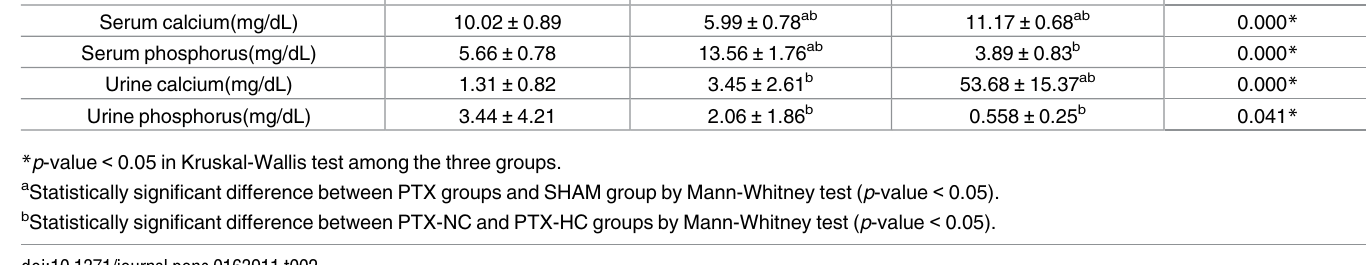
Table 2. Serum and urine calcium and phosphorus levels on postoperative 8 weeks. Data are expressed as the mean ± standard deviation. SHAM P -value Serum